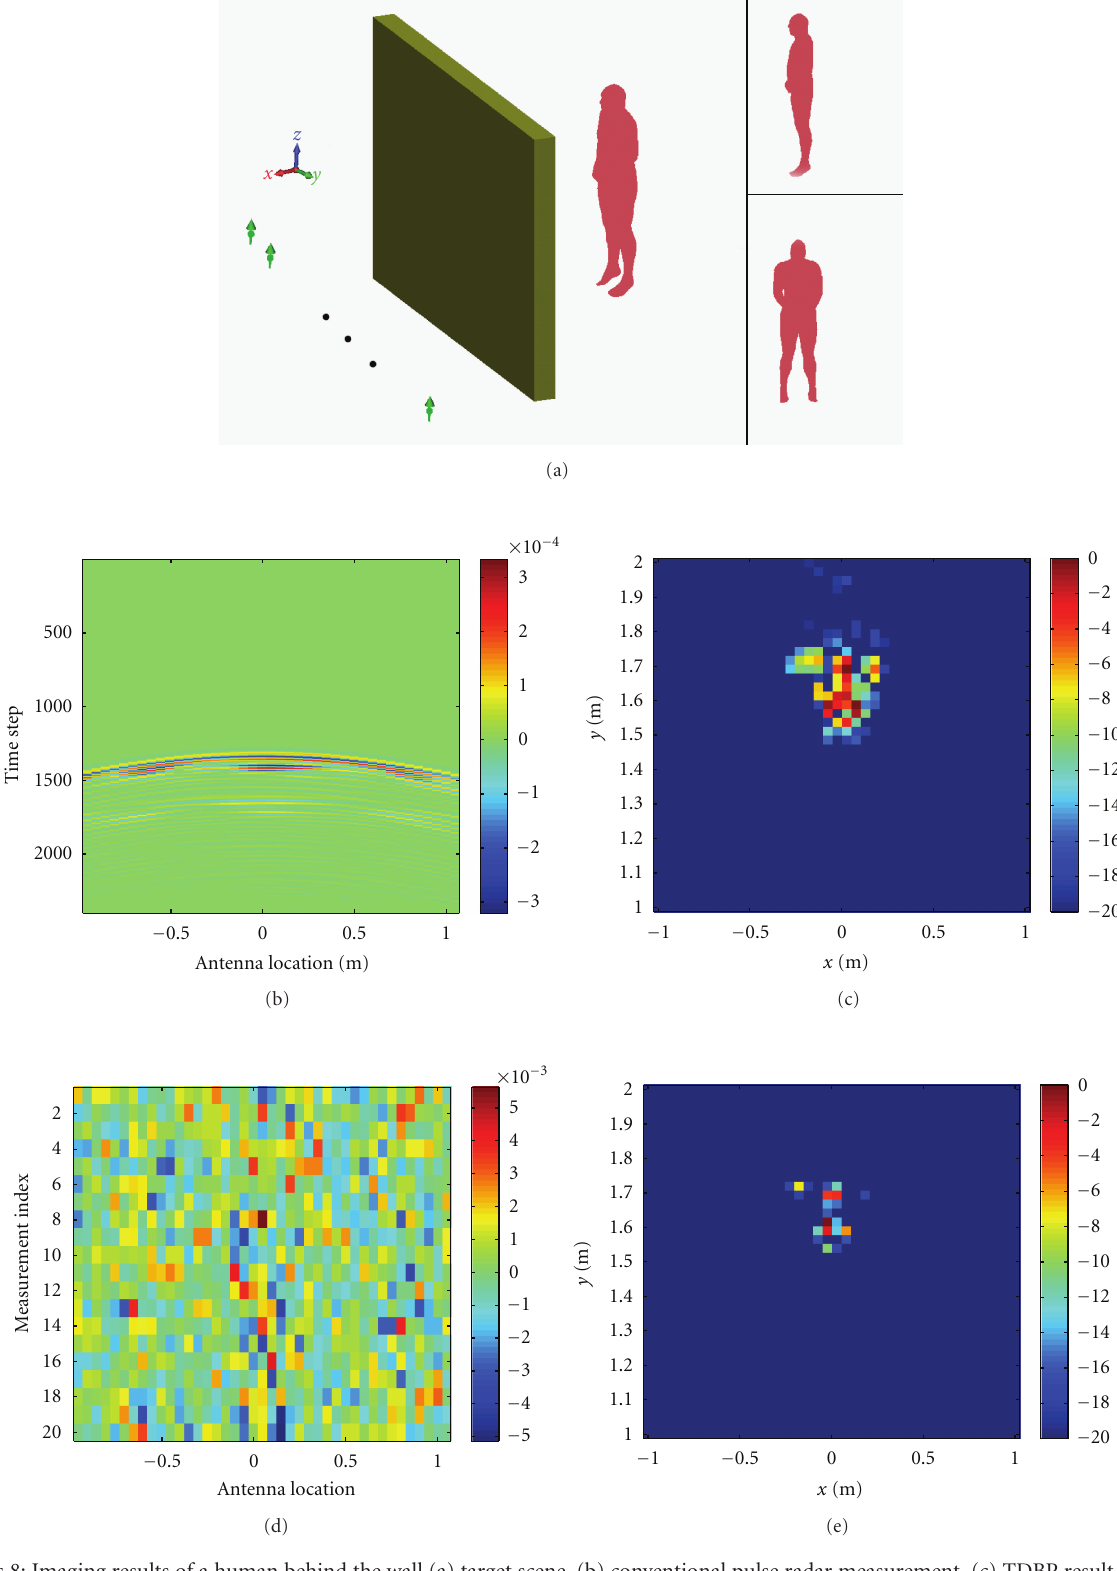
Figure 8: Imaging results of a human behind the wall (a) target scene, (b) conventional pulse radar measurement, (c) TDBP result, (d) CS measurement, and (e) CS